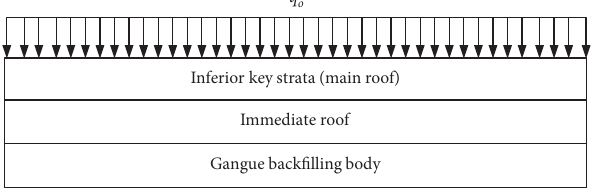
Figure 7: Schematic diagram of strata